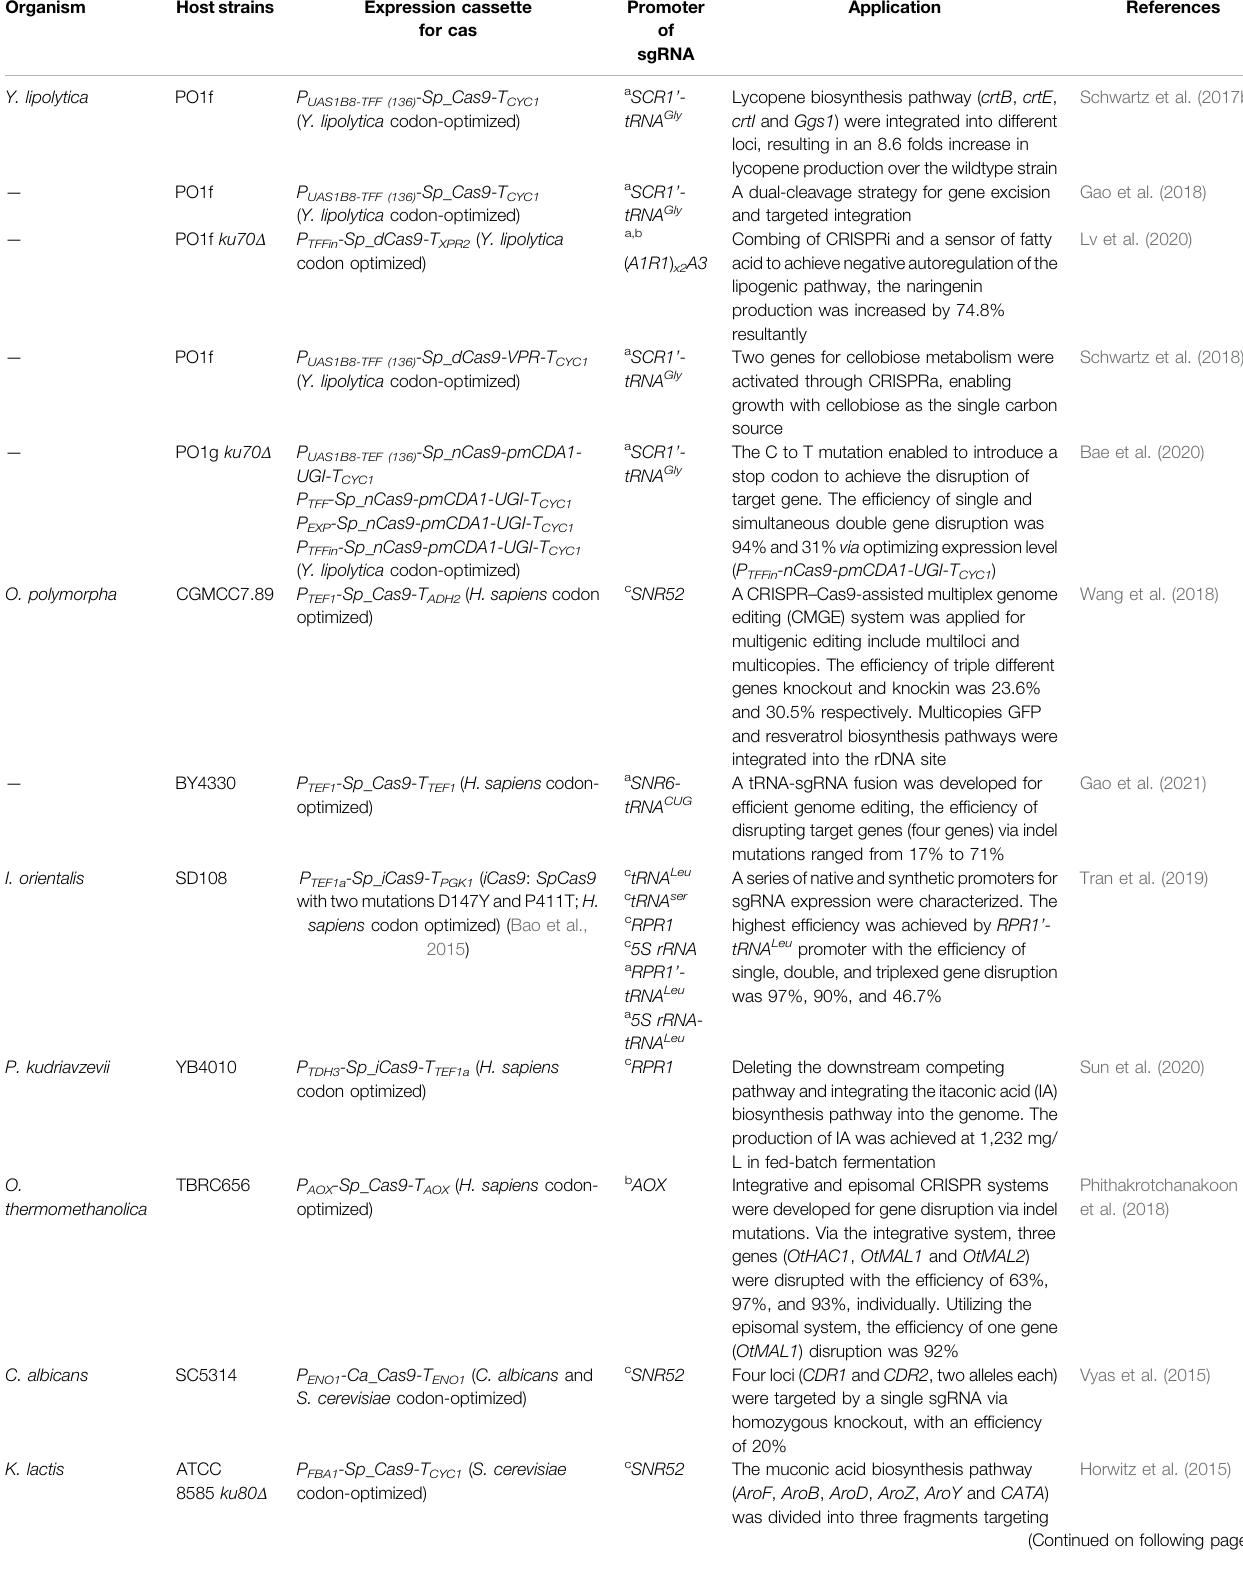
TABLE 1 | Genetic editing applications of CRISPR/Cas in non-conventional yeasts.